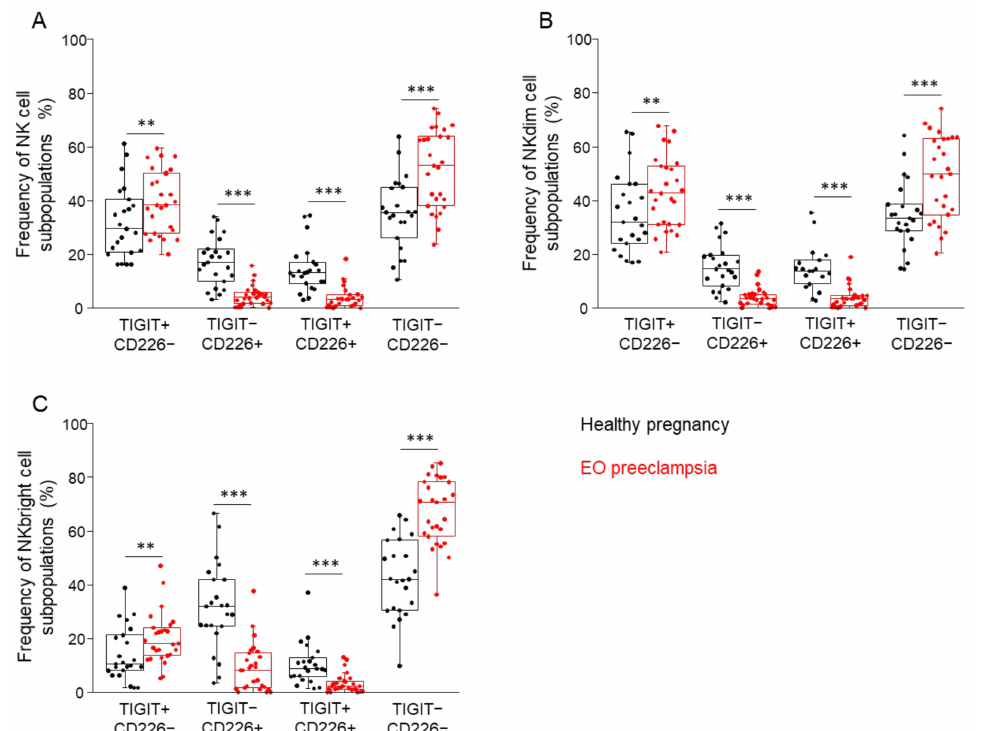
Figure 5. The frequency of the investigated NK cell subpopulations is based on the presence or absence of TIGIT and CD226 receptors in women with EO preeclampsia and healthy pregnant women. The frequency of NK- ( A ), NKdim- ( B ), and NKbright ( C ) cell subpopulations is based on the surface presence or absence of the TIGIT and CD226 receptors in women with EO preeclampsia and healthy pregnant women. The solid bars represent medians of 24 and 27 determinations, respectively, the boxes indicate the interquartile ranges, and the lines show the most extreme observations. Differences were considered statistically significant for p -values < 0.05 **, p < 0.01 ***.